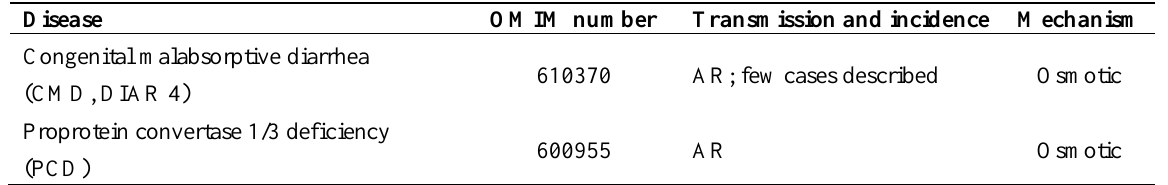
Table 3. Inheritance, epidemiology and pathological mechanisms of the defects of enteroendocrine cells differentiation.